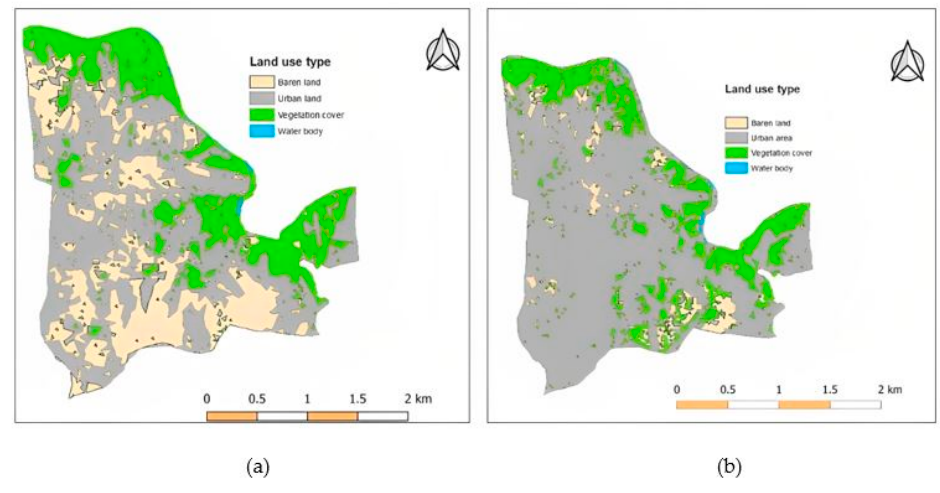
Figure 2. Land use classification maps over the twenty years respectively, ( a ) 2005; ( b ) 2020.